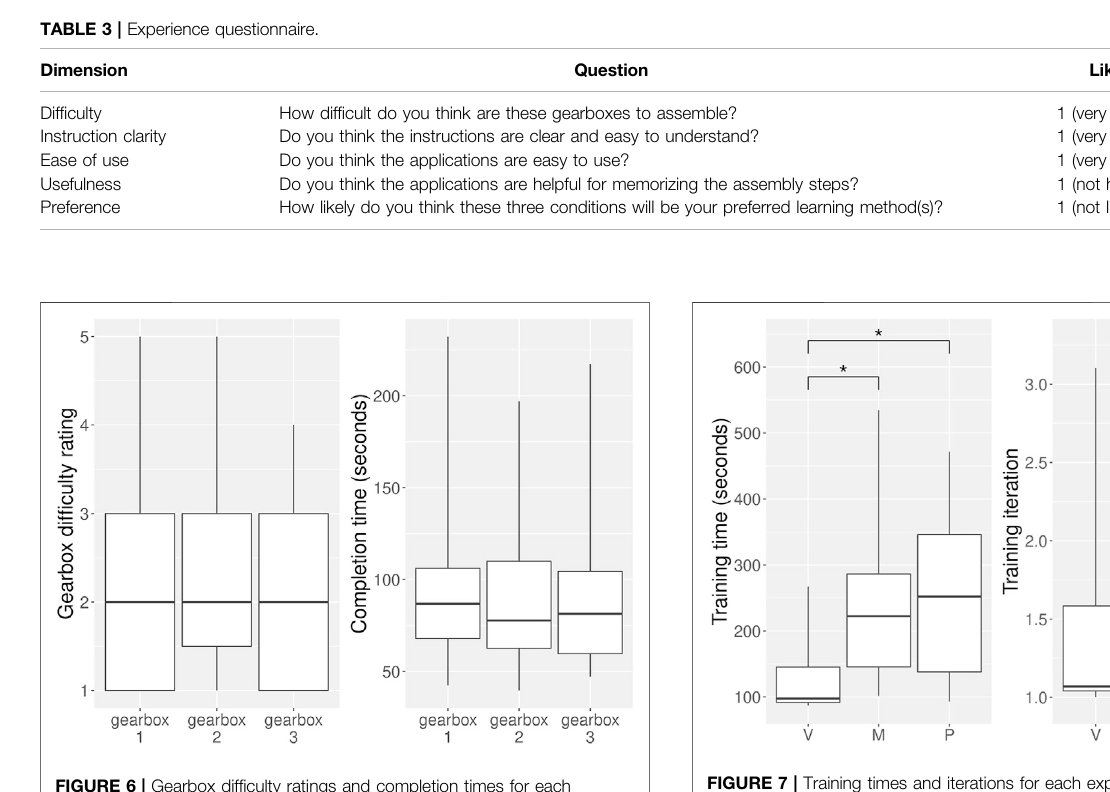
FIGURE 6 | Gearbox dif fi culty ratings and completion times for each gearbox in the immediate test.